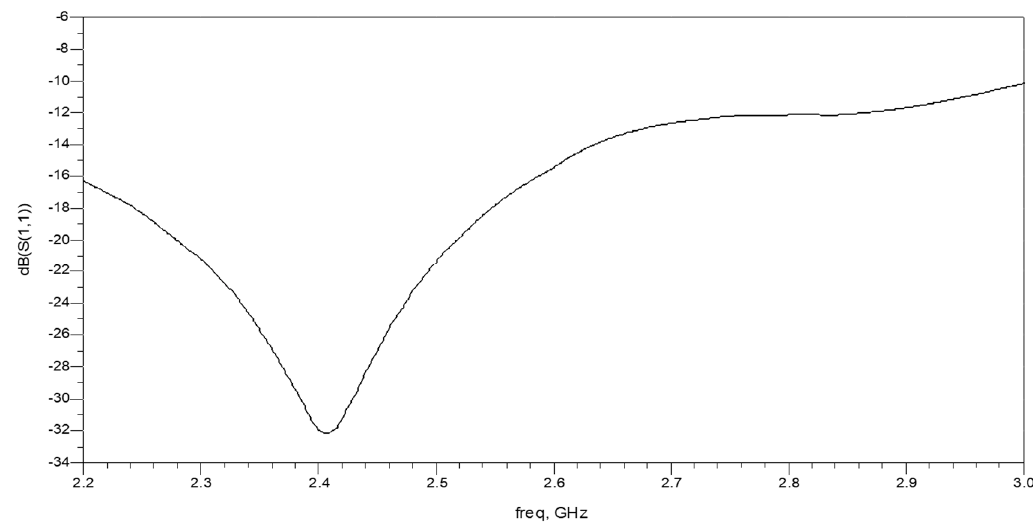
Figure 11. Active Circular Transmitting Patch antenna for Internet of Things (IoT) and 5G Applications.